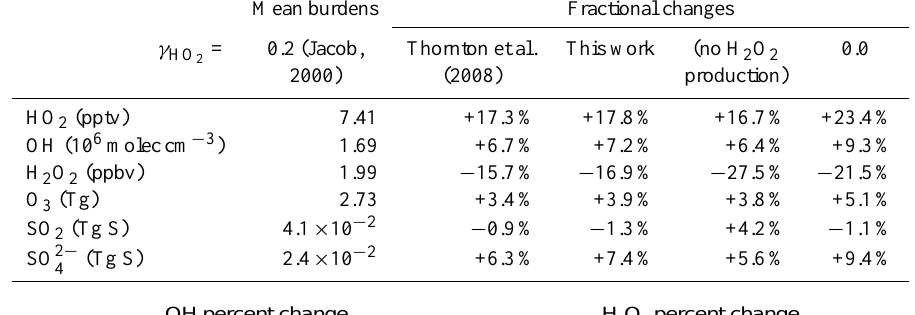
Table 3. As Table 2 but with the analysis restricted to below 5km over China (bounded by 97.5 ◦ E to 127.5 ◦ E longitude and 20 ◦ S to 44 ◦ N latitude.).